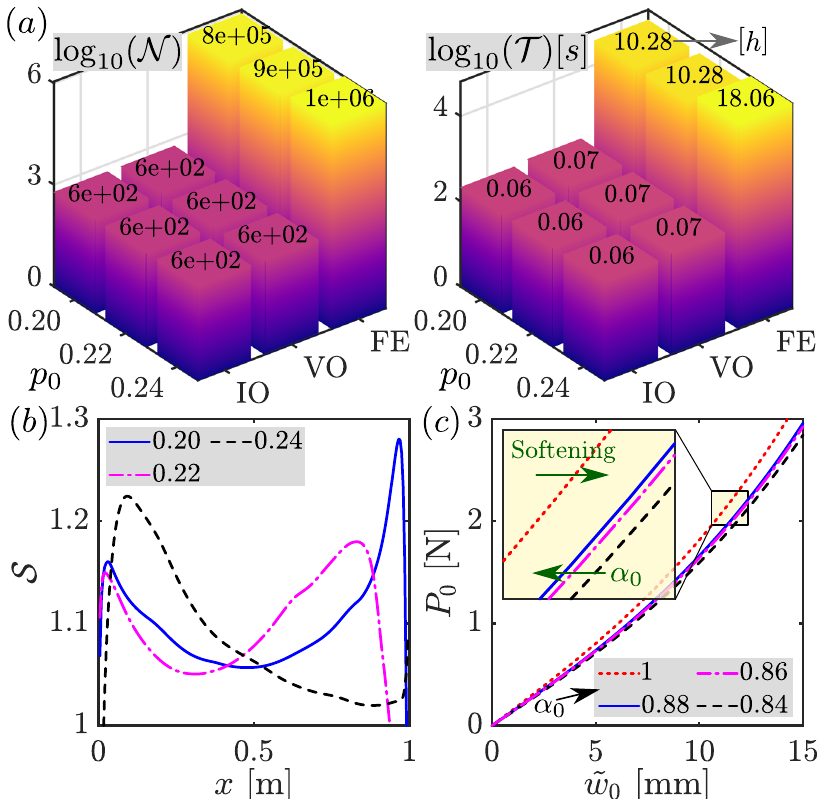
Fig. 5 Computational performance and some theoretical implications of the VO model. a Performance of the 3D FE, VO, and IO approaches are compared in terms of the degrees of freedom ðNÞ and simulation times ðT Þ . For a better understanding, values of N and T (in hours) are provided on the top of each bar. b , c Impact of nonlocal effects: b position-dependent softening of the porous beams across the symmetric axis. c Consistent softening of the porous beams with an increase in the degree of nonlocality (that is, a decrease in the average VO α 0 ). The dark-green arrows depict the direction in which either the average VO α 0 or the degree of softening